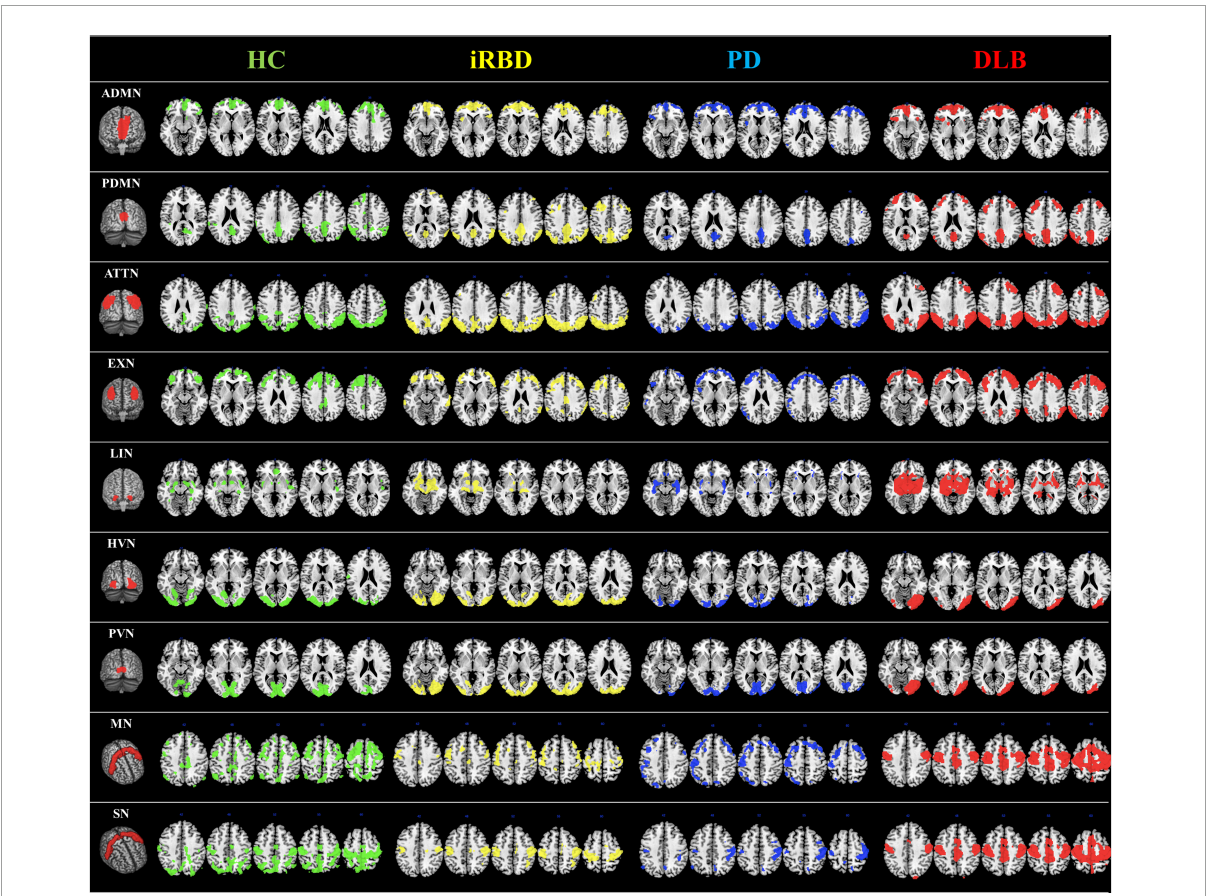
FIGURE1 RSNs analysis. RSNs topography in HC (green overlaid to the anatomical template), iRBD (yellow overlaid to the anatomical template), PD (blue overlaid to the anatomical template), and DLB (red overlaid to the anatomical template) for the ADMN, PDMN, ATTN, EXN, LIN, HVN, PVN, MN, and SN. The selected seed for each network is shown in the first column. A connectivity derangement is present in all the RSNs. RSNs were obtained using seed-based intercorrelation analysis. Clusters with a minimum spatial extent of 100 voxels are shown, with a voxel-wise significant threshold of p = 0.001. iRBD, isolated REM sleep behavior disorder; PD, Parkinson’s disease; DLB, dementia with Lewy Bodies; HC, healthy controls; ADMN, anterior default mode network; ATTN, attentive network; EXN, executive network; HVN, high visual network; LIN, limbic network; MN, motor network; PDMN, posterior default mode network; PVN, primary visual network; SN, somatosensory network.